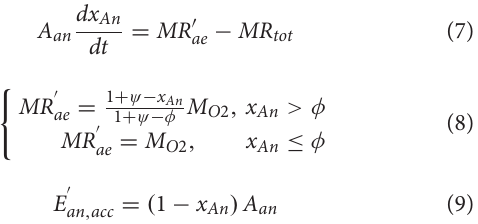
of the aerobic system. Both φ and ψ are considered individual parameters of the model, but they have no direct physiological analogy. The adjusted model of Morton (2006) in this study is henceforth referred to as the two-tank model